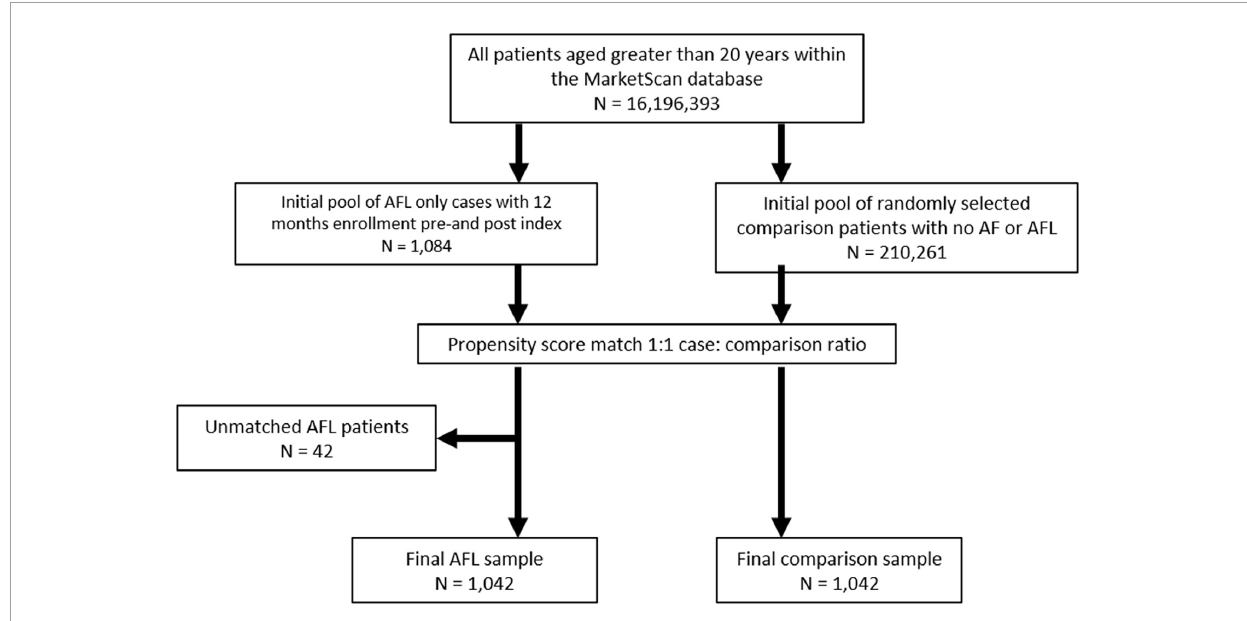
FIGURE1 Patient identification